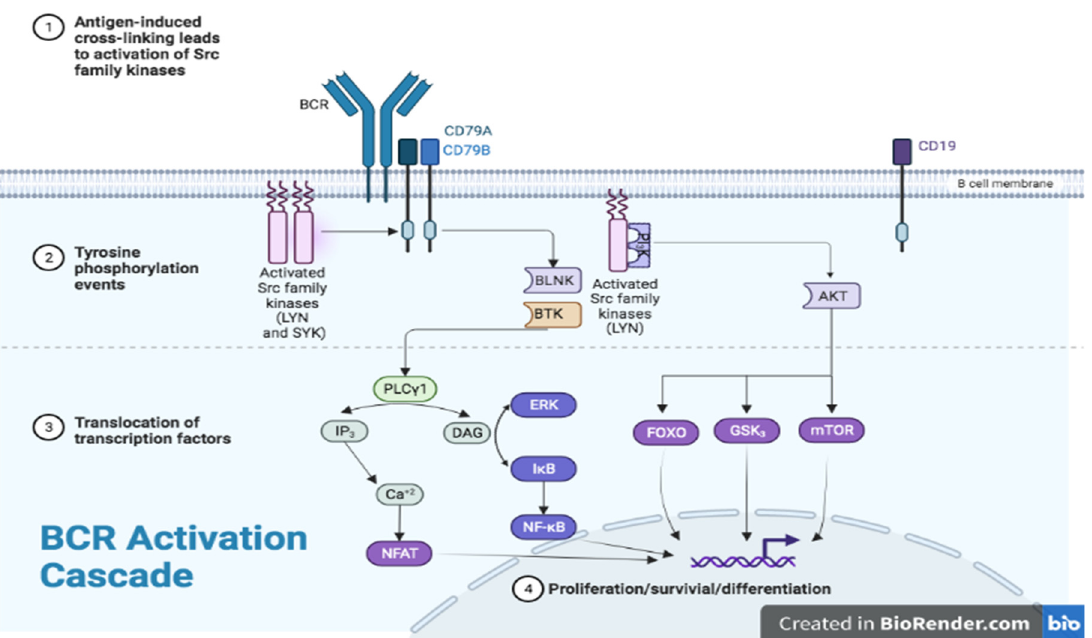
Figure 2. Role of BTK in antigen dependent BCR signaling pathway that regulates B-cell proliferation and survival [23] .